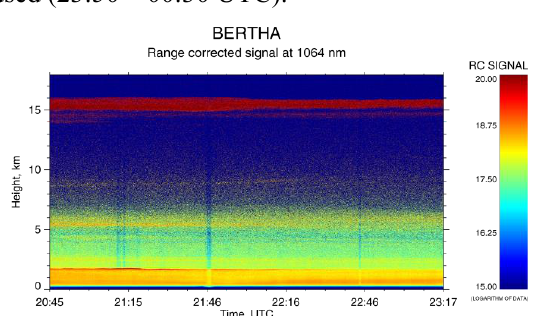
Fig.1. BERTHA RCS at 1064 nm, showing the smoke layers advected from Canada over Leipzig, in the troposphere (5 – 6 km) and in the stratosphere (15 – 16